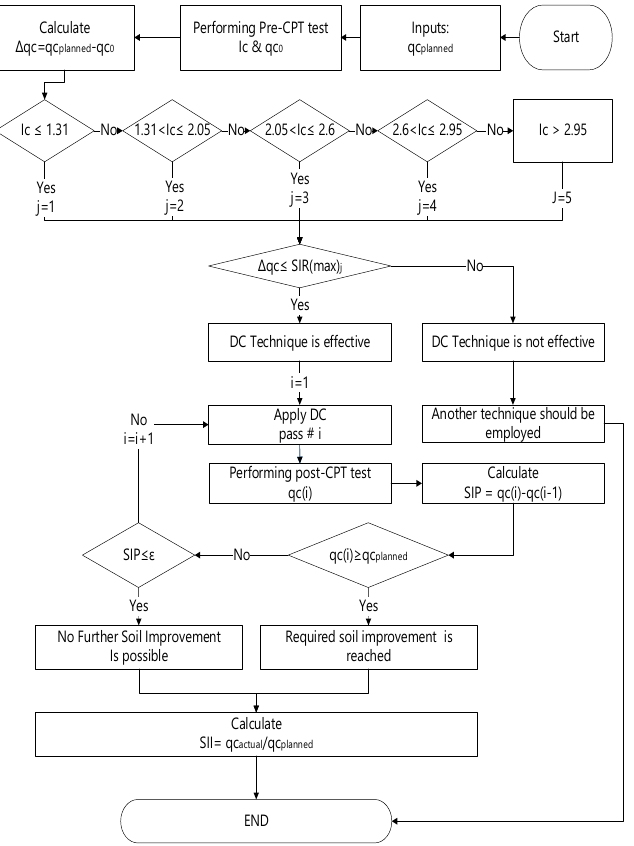
Figure 1. Proposed evaluation and assessment framework for implementation of DC technique.